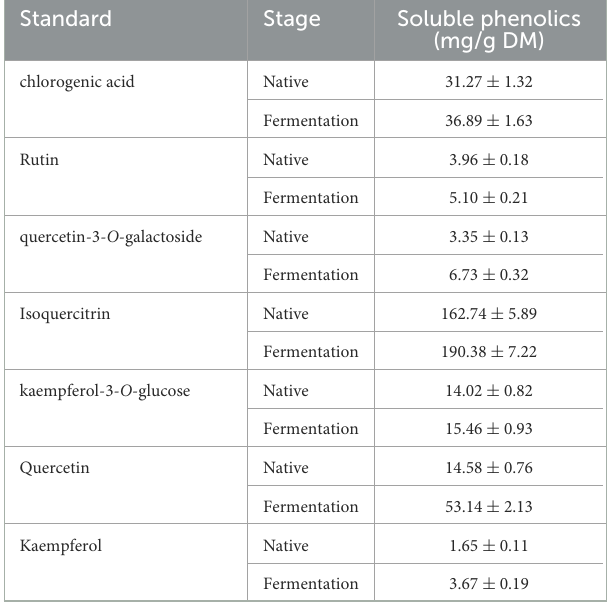
TABLE 4 Changes in individuals of soluble phenolics in the EA subfraction of AVL fermented with A. niger